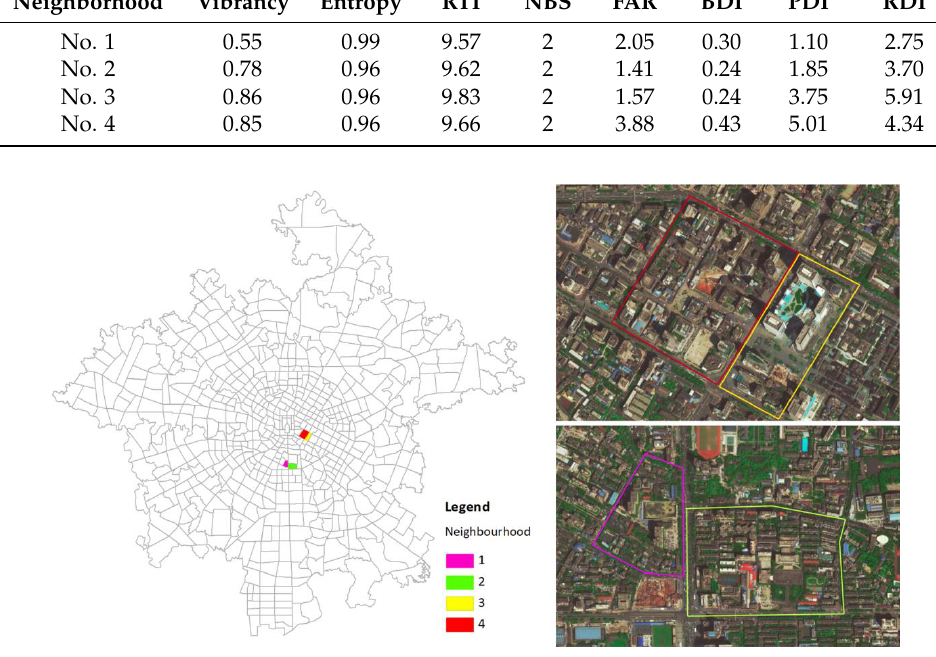
Figure 4. Four neighborhoods with different urban forms.